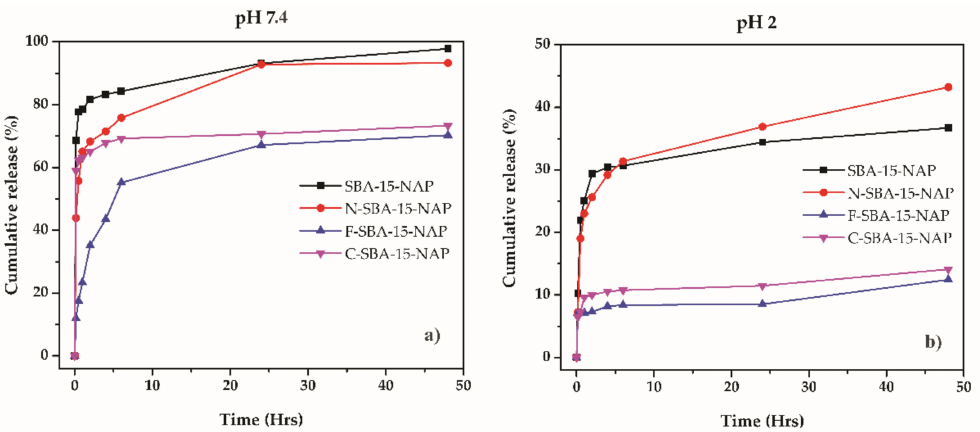
Figure 10. Release curves obtained using HPLC at ( a ) pH 7.4 and ( b ) pH 2 for SBA-15-NAP, N-SBA-15-NAP, F-SBA-15-NAP, and